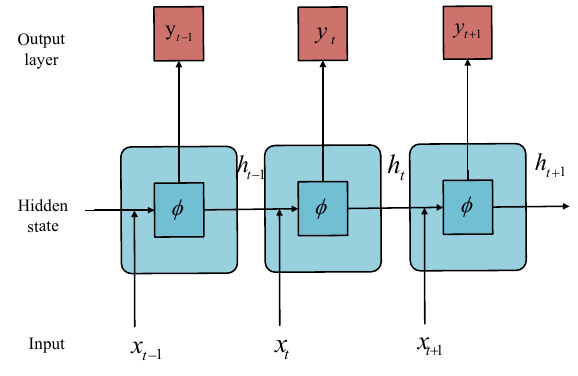
Figure 2. Structure of RNN.